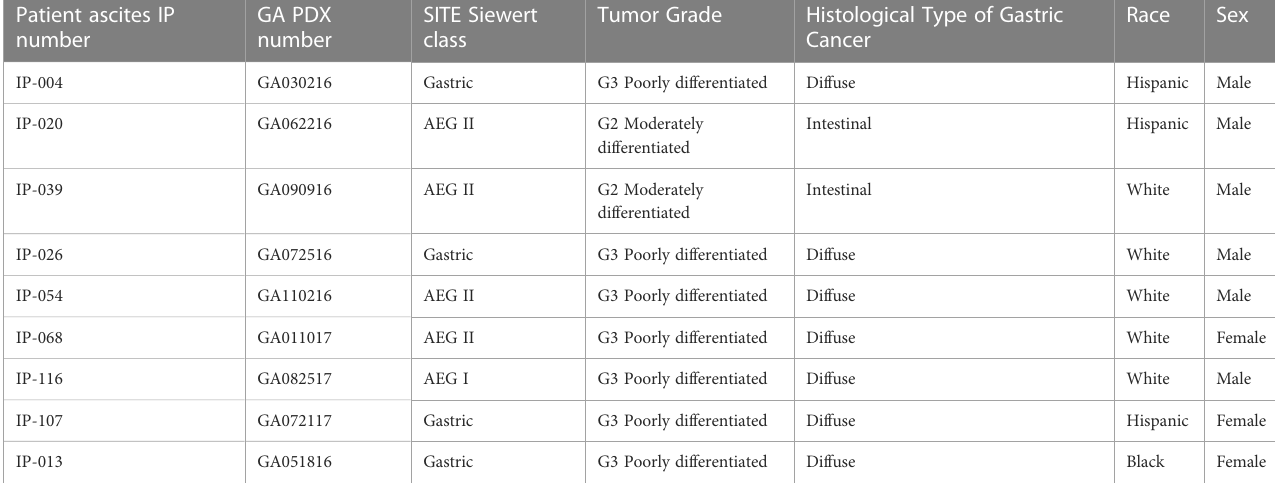
TABLE 1 Patient ascites of gastric cancers and their corresponding PDX tumors used in this study. Patient ascites IP